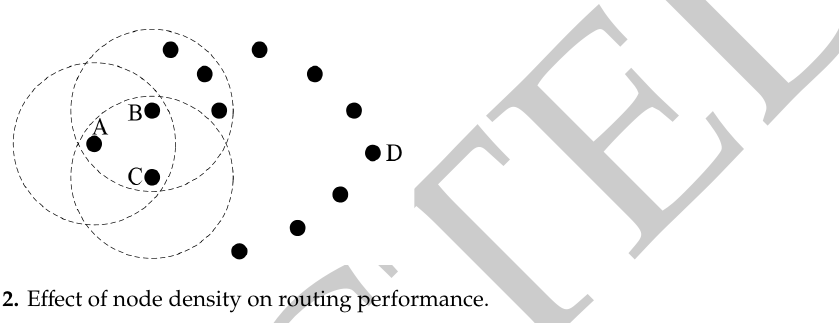
Figure 2. Effect of node density on routing performance. Figure 2. E ff ect of node density on routing